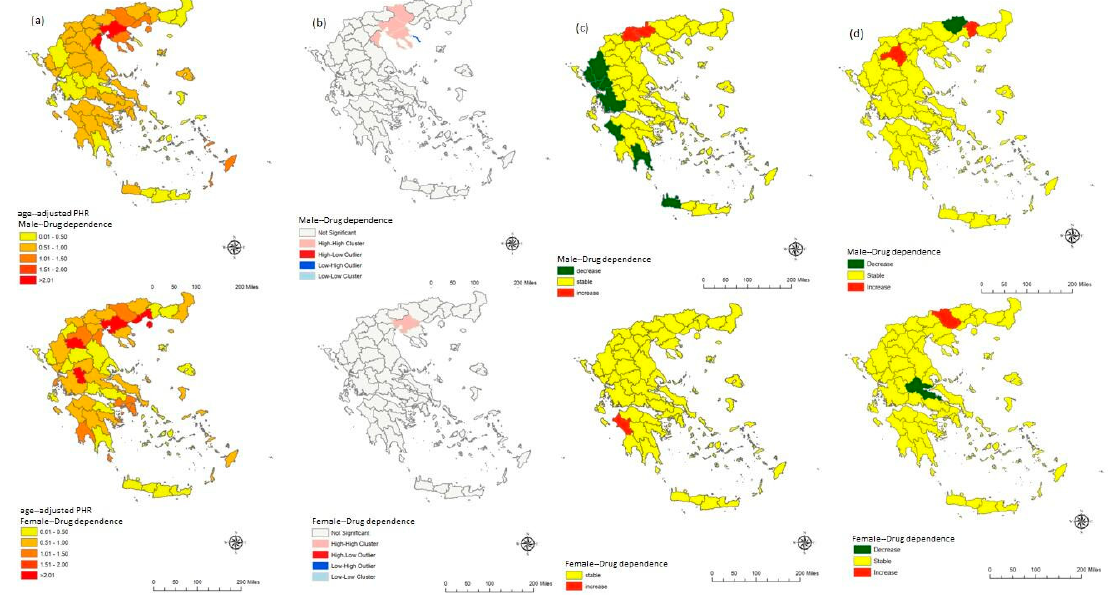
Figure 5 . Descriptive ( a ), LISA ( b ) time series of annual PHR values ( c ) and hospitalization days ( d ) maps per sex for hospitalizations of patients with drug dependence syndrome from 1999 to 2012 in Greece.